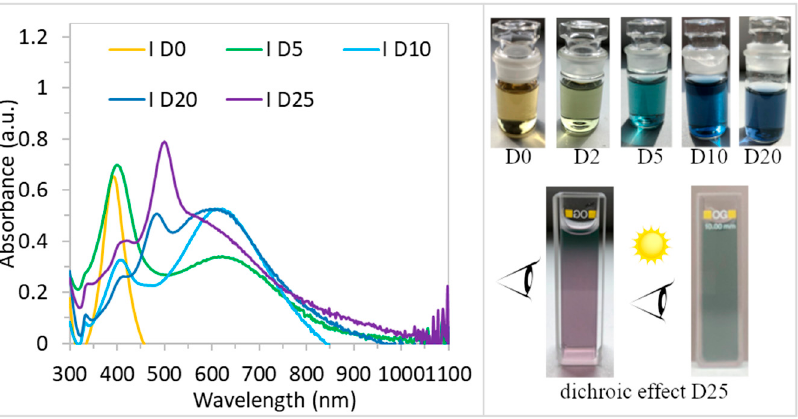
Figure 4. UV–vis spectra of AgNPs colloids (sample I) and colloid color changes with time.